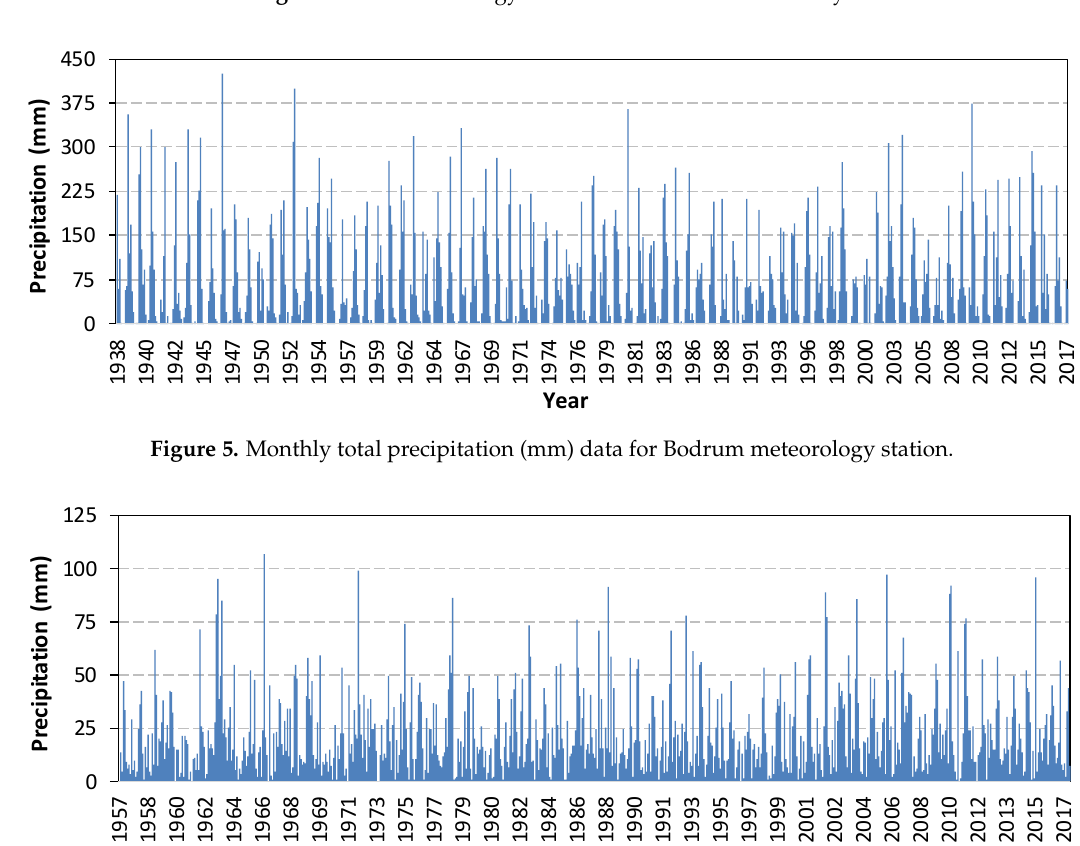
Figure 4. The meteorology stations considered in this study.